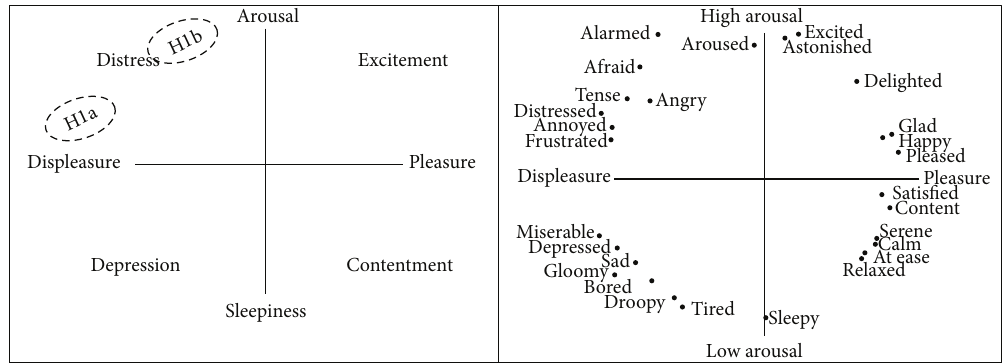
Figure 2: Two schematics of Russell’s circumplex model of affect [28]. As we are less interested in semantic meaning than we are in the physiological responses related to our experimental stimuli, we focus on the model to the